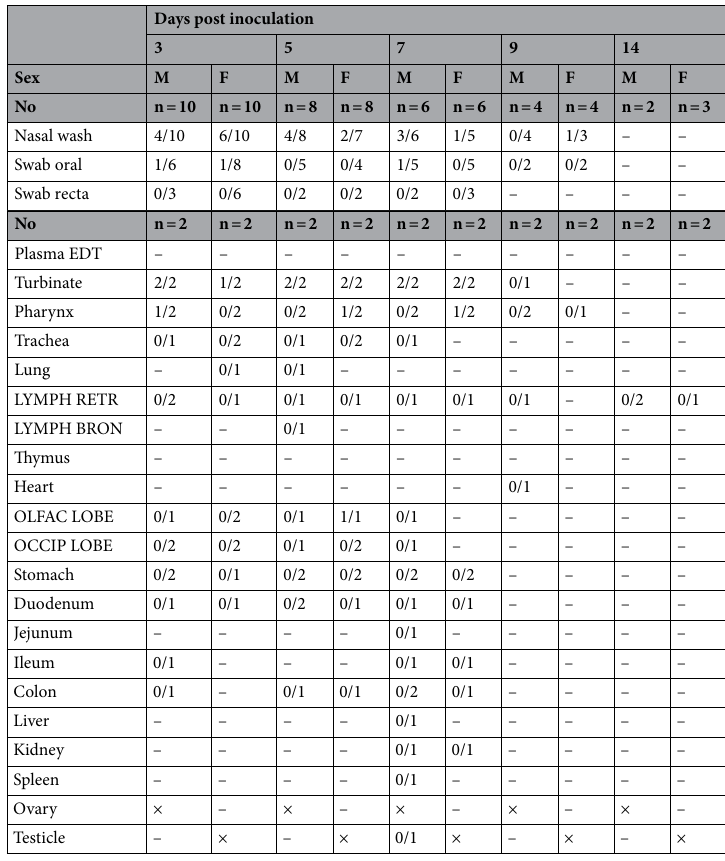
Table 2. Recovery of infectious virus from qRT-PCR positive shedding samples and tissues after in- tranasal challenge of ferrets with SARS-CoV-2. The numerator indicates the number of samples that were positive by infectivity assay (> 92.8 TCID 50 /mL). The denominator indicates the number of qRT-PCR positive samples tested. × indicates not applicable. LYMPH RETR the retropharyngeal lymph node, LYMPH BRON the bronchial lymph node, OLFAC LOBE the olfactory bulb, OCCIP LOBE the occipital lobe